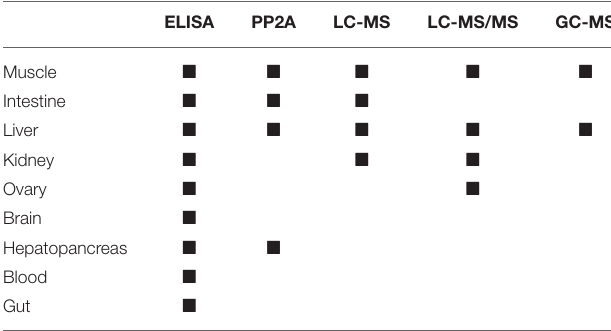
TABLE 4 | Microcystin (MC) quantification methods for which significant differences in MC concentrations between tissue types were detected by bootstrap